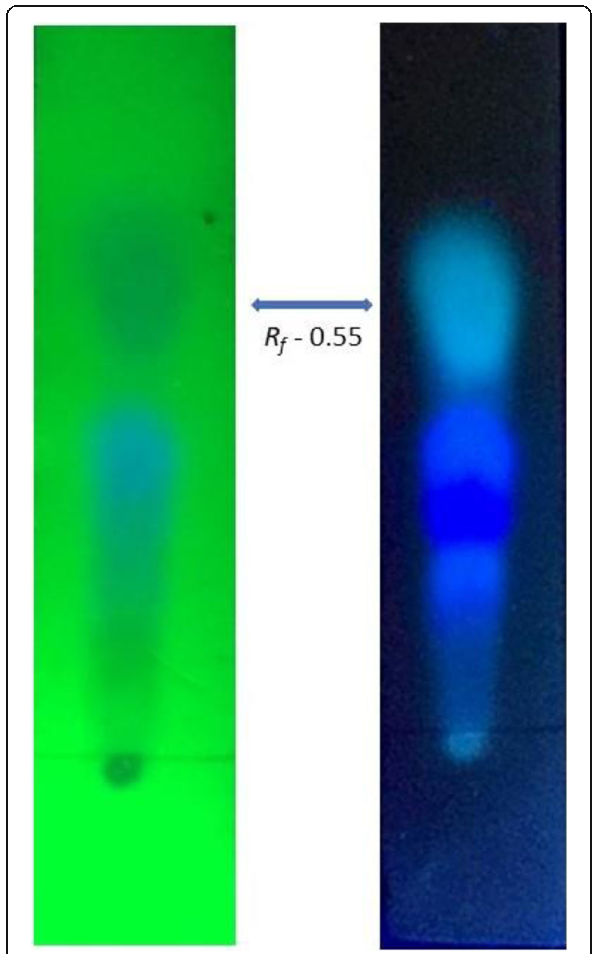
Fig. 5 Thin-layer chromatogram of ethyl acetate extract of Streptomyces misionensis MI22 ( a = 254 nm; b = 365 nm) showing an active band at R f 0.55 responsible for anti-microbial